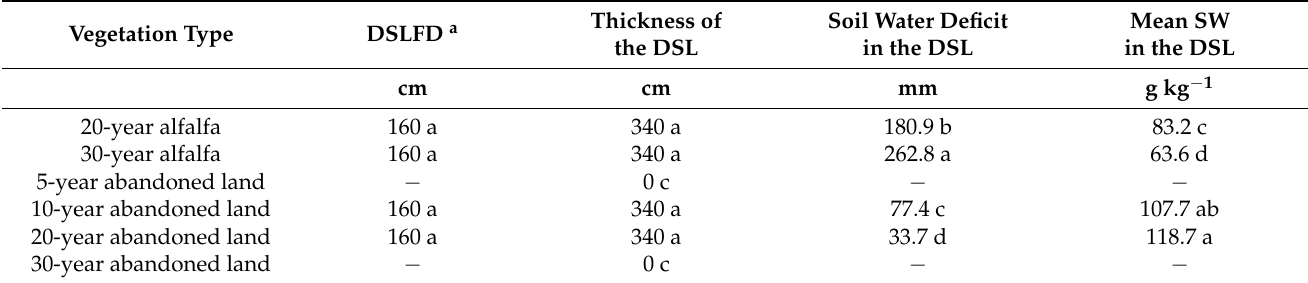
Figure 6. Effects of land use on soil desiccation index in the 0 − 500 cm soil profiles under long-term wheat, maize and Caragana korshinskii Kom ( A ), alfalfa ( B ) and abandoned land ( C